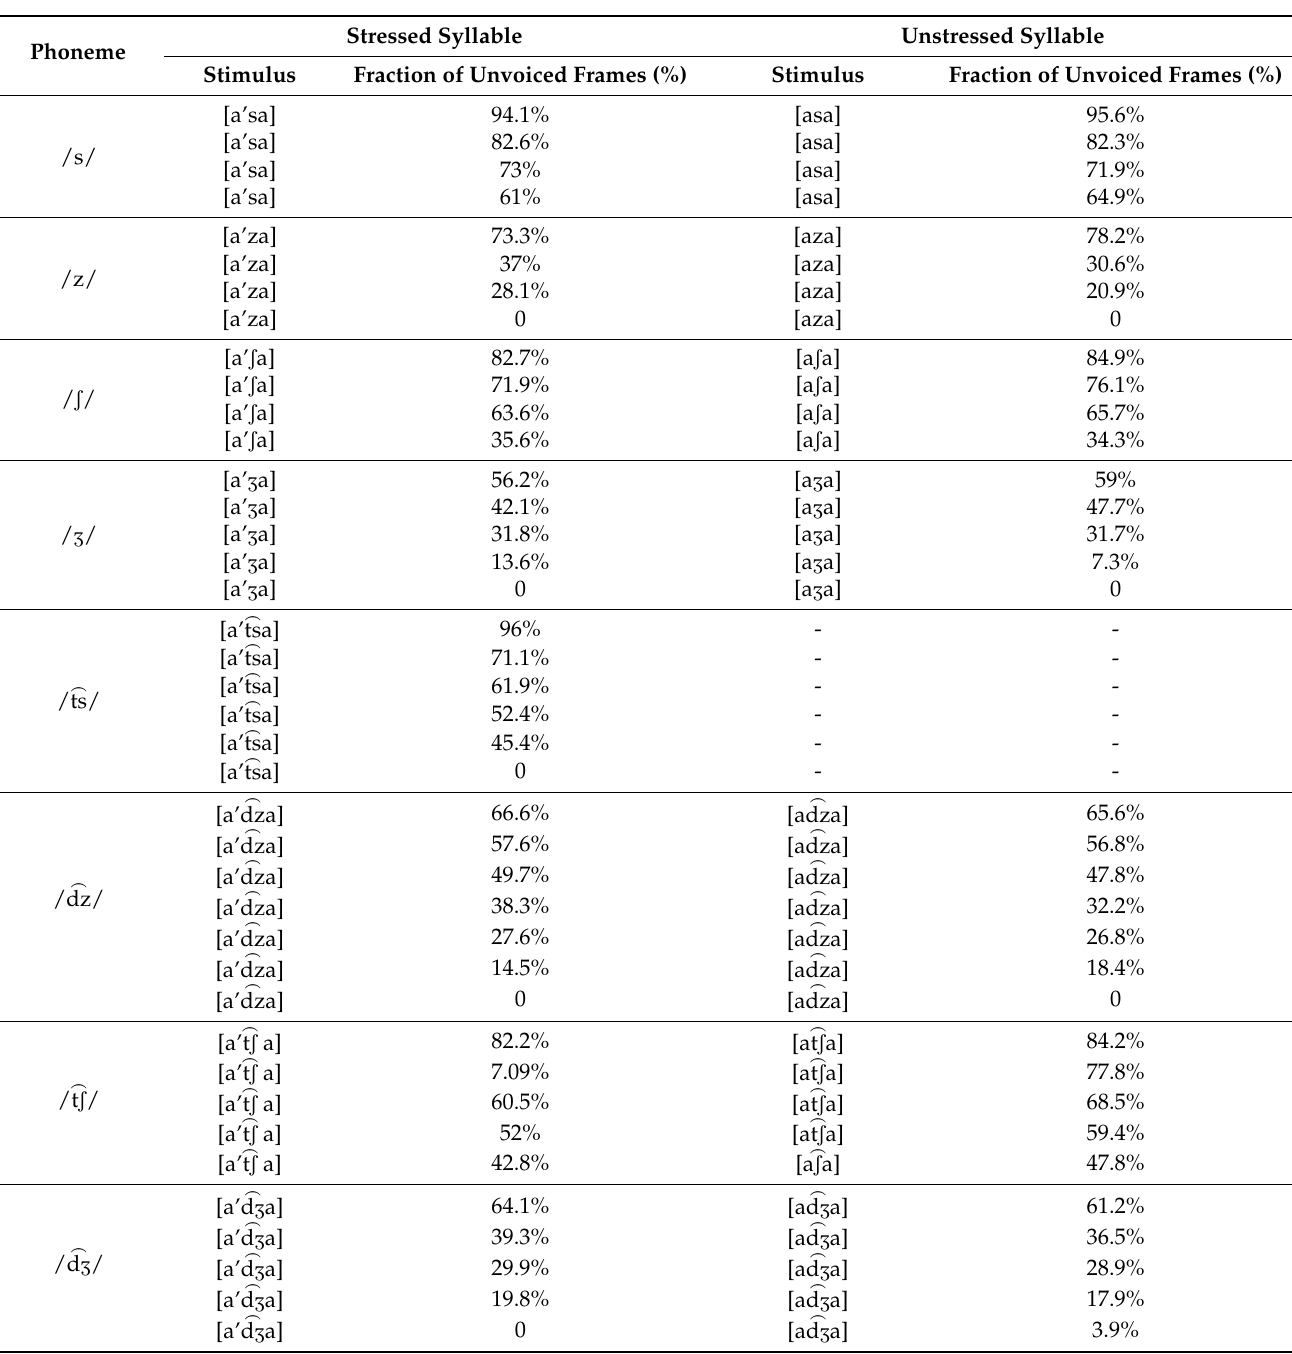
Table A1. Stimuli used in the perception